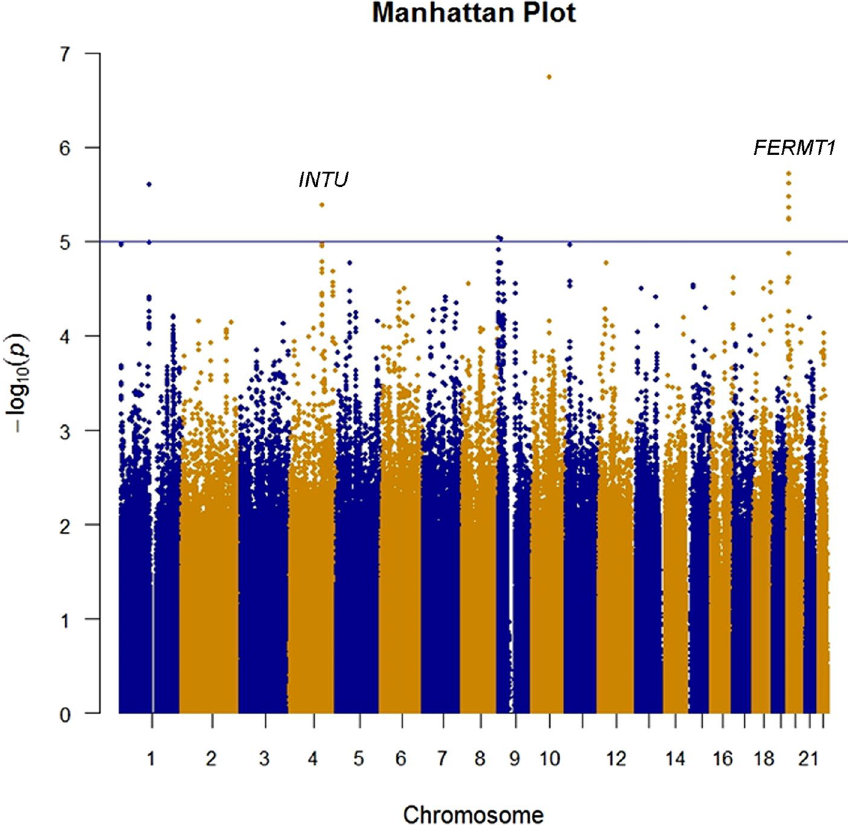
Figure 4. Imputation of GWAS. Results of genome-wide association analysis (− log 10 P ) presented in chromosomal order for 4,566,885 SNPs imputed for association between 126 endometriosis and 96 non- endometriosis control. The x axis shows each of the SNPs used in the discovery phase. The y axis shows the − log 10 P value of the trend test. Signals in inturned planar cell polarity protein ( INTU ) and fermitin family member 1 ( FERMT1 ) loci are presented. SNP single nucleotide